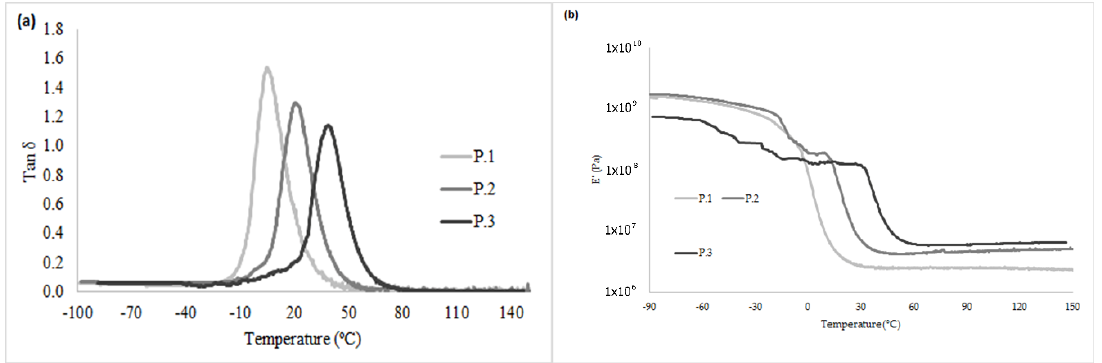
Figure 7. DMTA thermograms of the synthesized PUs. ( a ) Loss factor; ( b ) Storage modulus.